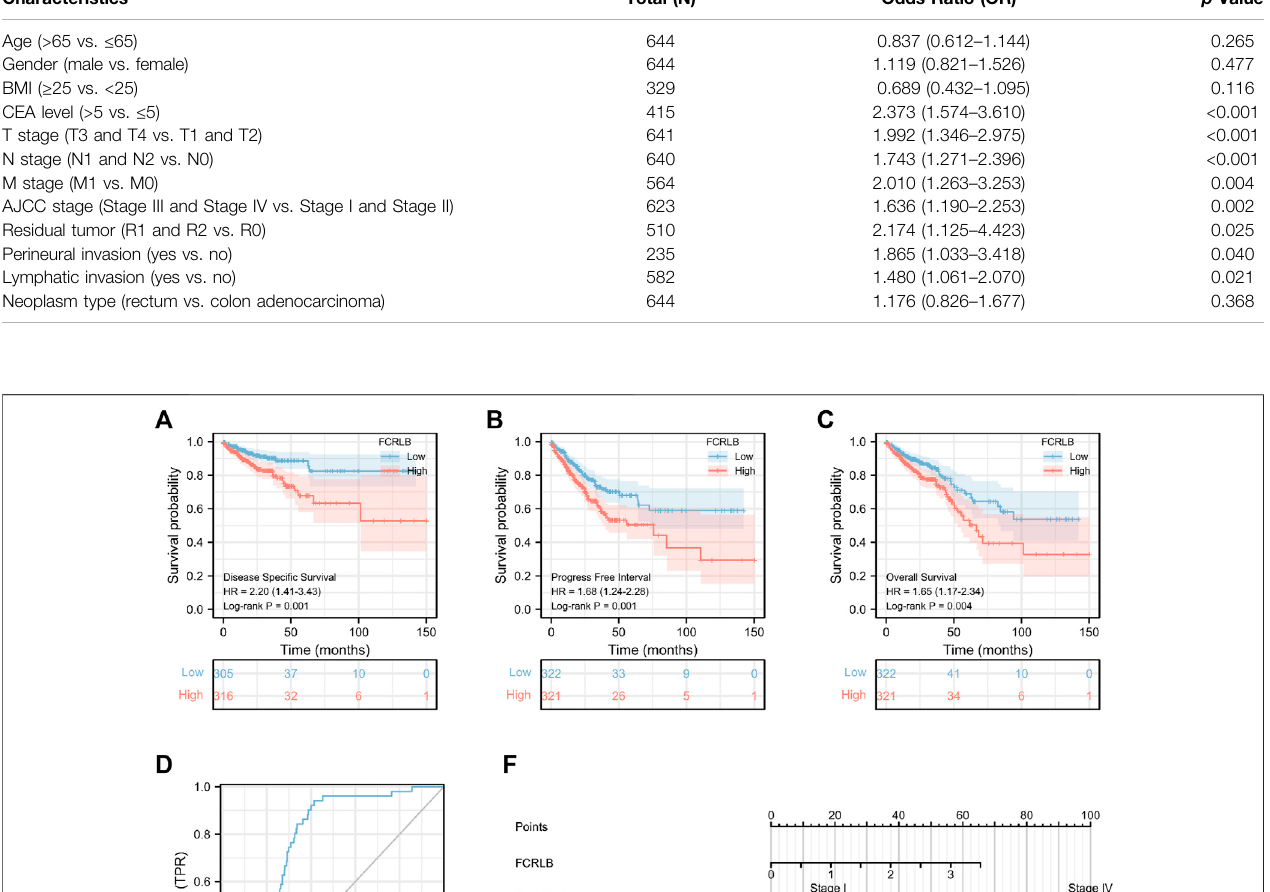
Frontiers in Genetics |